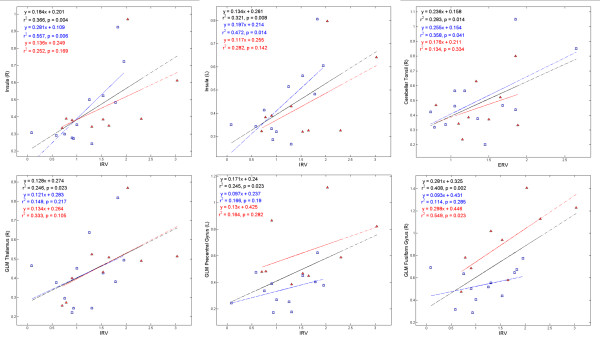
Correlations between the pulmonary functions and the amount of BOLD signal change. IRV: inspiratory reserve volume; ERV: expiratory reserve volume (ERV). Fitting lines, symbols and texts in blue color represent relevant information of the HA group, whereas fitting lines, symbols and texts in red color represent relevant information of the SL group, and those in black color represent corresponding information from the overall subject pool including both groups.